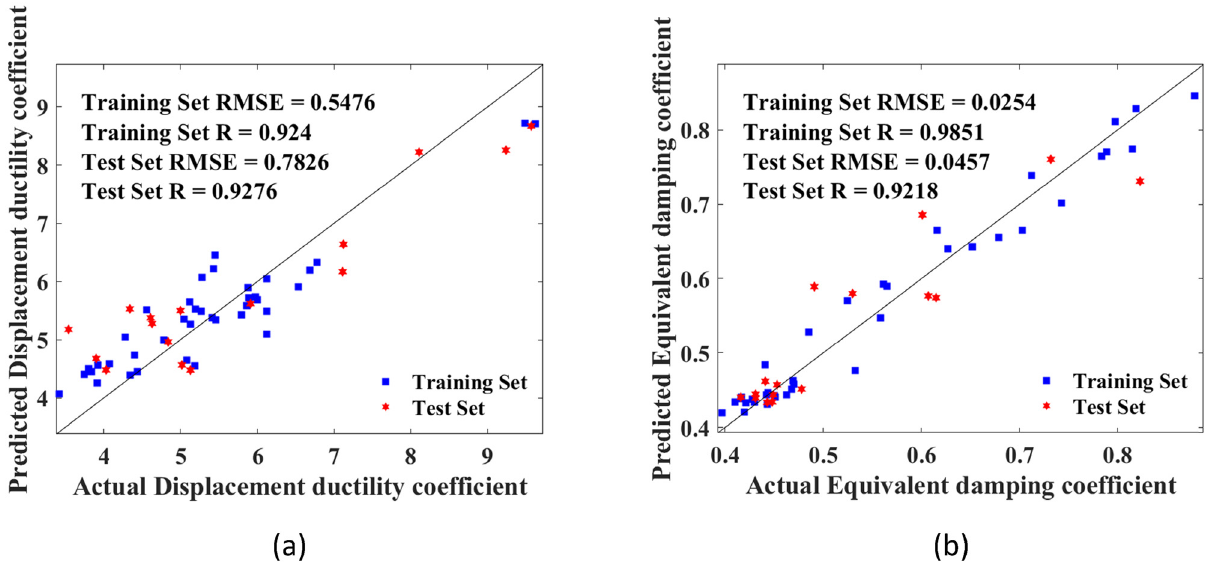
Figure 18: Scatter plot of simulated and actual values for training and test sets: ( a ) displacement ductility coe ffi cient prediction and ( b ) equivalent damping coe ffi cient prediction.